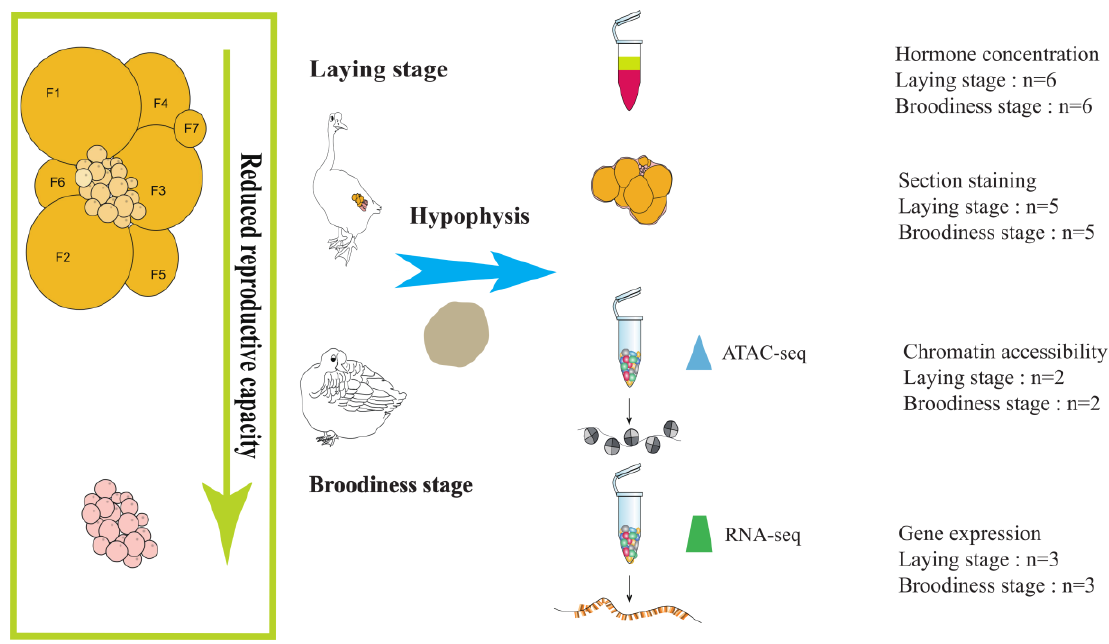
Figure 1. Schematic diagram of experimental design. Ovarian tissue from the laying and broodiness groups was extracted to make sections and stain for hematoxylin–eosin staining (H&E staining) ( n = 5). Serum samples of pituitary tissue from the laying and broodiness groups were extracted for hormone concentration determination ( n = 6). Nuclei were extracted from pituitary tissues from the laying and broodiness groups for ATAC-seq ( n = 2), and RNA-seq ( n = 3). “n” represents the sample size in each experiment. F1 to F6 means the largest hierarchy of preovulatory follicles present in laying stage of